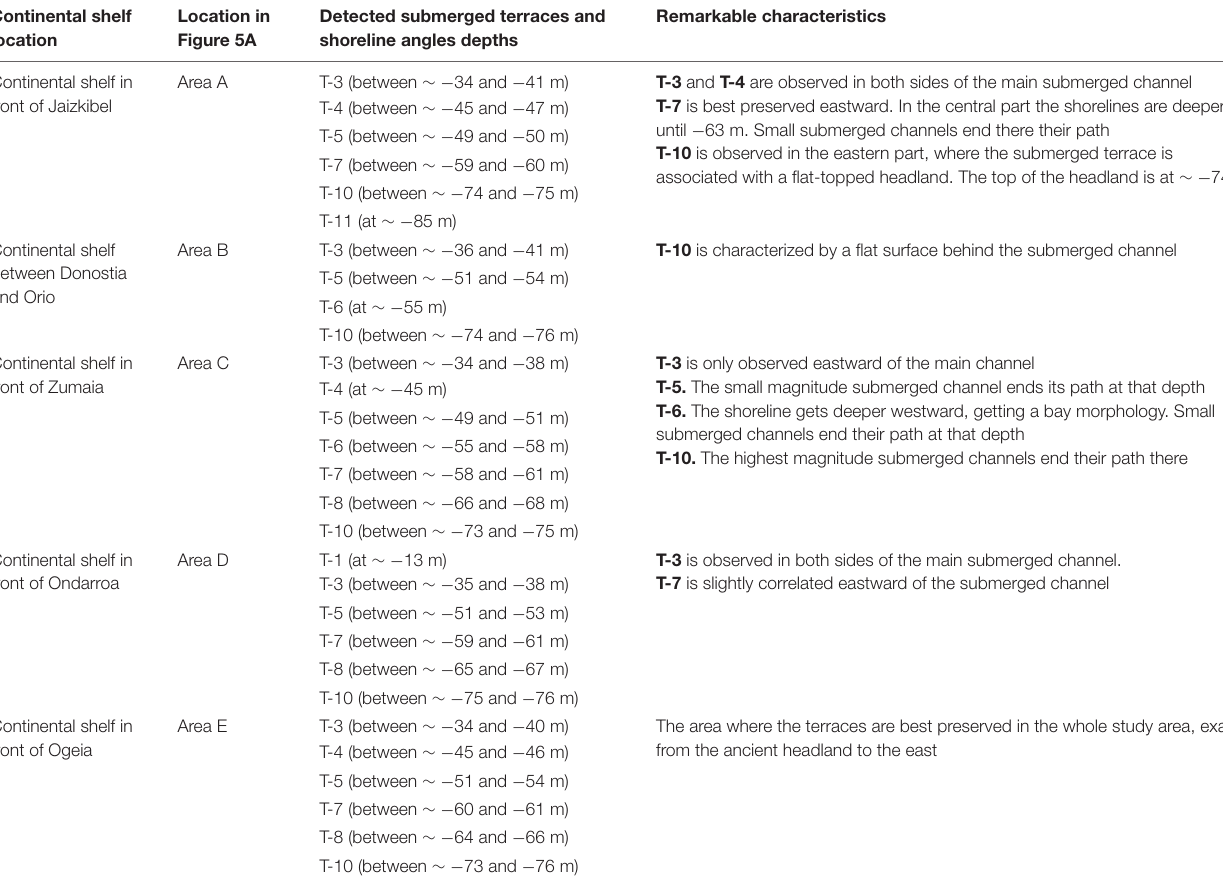
TABLE 1 | Submerged marine terrace distribution from Jaizkibel to Ogeia in segments of the continental shelf with the most remarkable